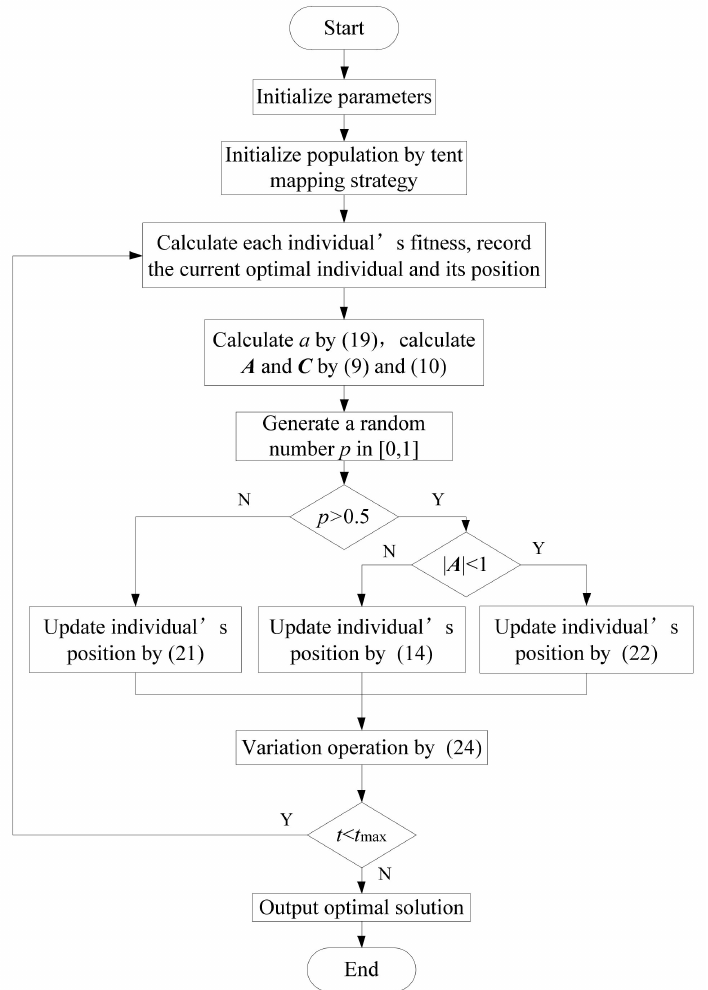
Figure 4. Flow diagram of modified whale optimization